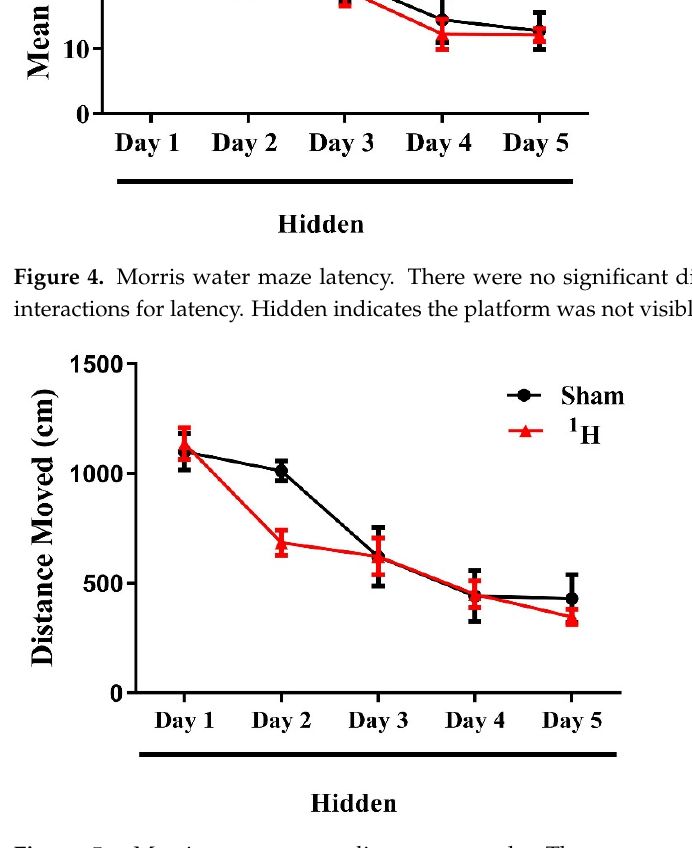
Figure 5. Morris water maze distance moved. There was a significant difference in time (F (2.9, 52.20) = 25.00, p < 0.001). Hidden indicates the platform was not visible during the training trials. For probe trial days, normal nonimpaired mice demonstrate spatial memory reten- tion by spending more time in the target quadrant as compared to the other quadrants. The sham-irradiated mice statistically spent more time in the target quadrant compared to the right, opposite, and left quadrants (F (3, 36) = 26.50, p < 0.0001). Similarly, 1 H-irradi- ated mice also spent more time in the target quadrant compared to the right, opposite, and left quadrants (F (3, 36) = 29.58, p < 0.0001; Figure 6). Figure 6. Morris water maze probe trials on day 5. Both the sham- and fractionated 1 H-irradiated mice spent more time in the target quadrant compared to the right, opposite and left quadrants. * p < 0.001. 3.3. Neurogenesis and Gliogenesis The fate of newly born cells was determined by quantifying cells that were double- labeled with BrdU + /NeuN for neurons, BrdU + /CD68 for activated microglia, and BrdU + /GFAP + for astrocytes. The presence of BrdU only represents the long-term survival of newly generated cells, independent of phenotype. 1 H-irradiated mice had a signifi- cantly lower number of BrdU + cells compared to sham-irradiated mice (t = 3.39, p < 0.05),